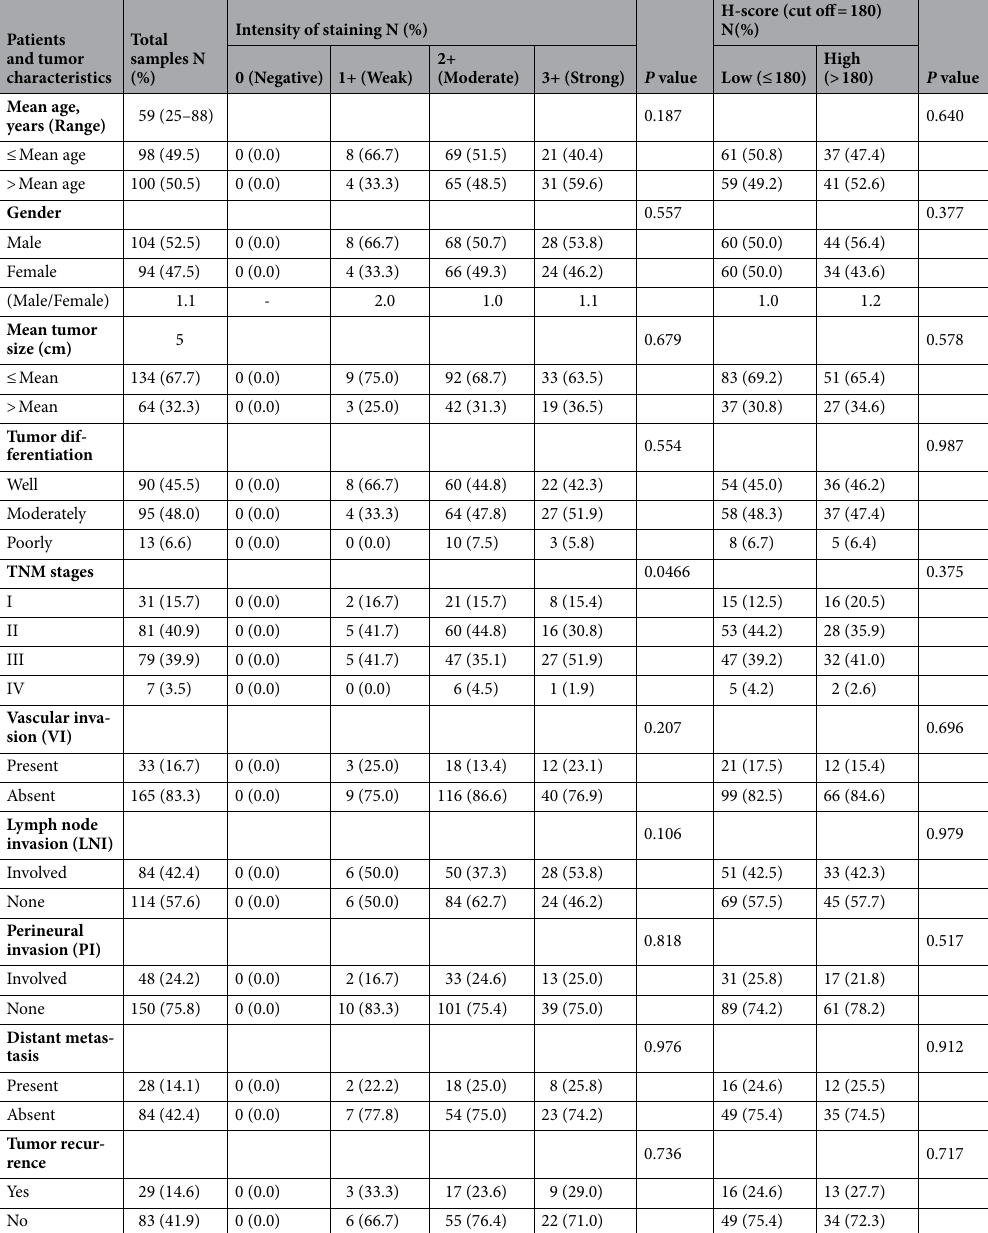
Table 4. The association between cytoplasmic DDIT4 expression and clinicopathological features of colorectal cancer (CRC) samples (Intensity of staining and H-score). P value ; Pearson’s χ 2 test, and Values in bold are statistically significant. H-score histological